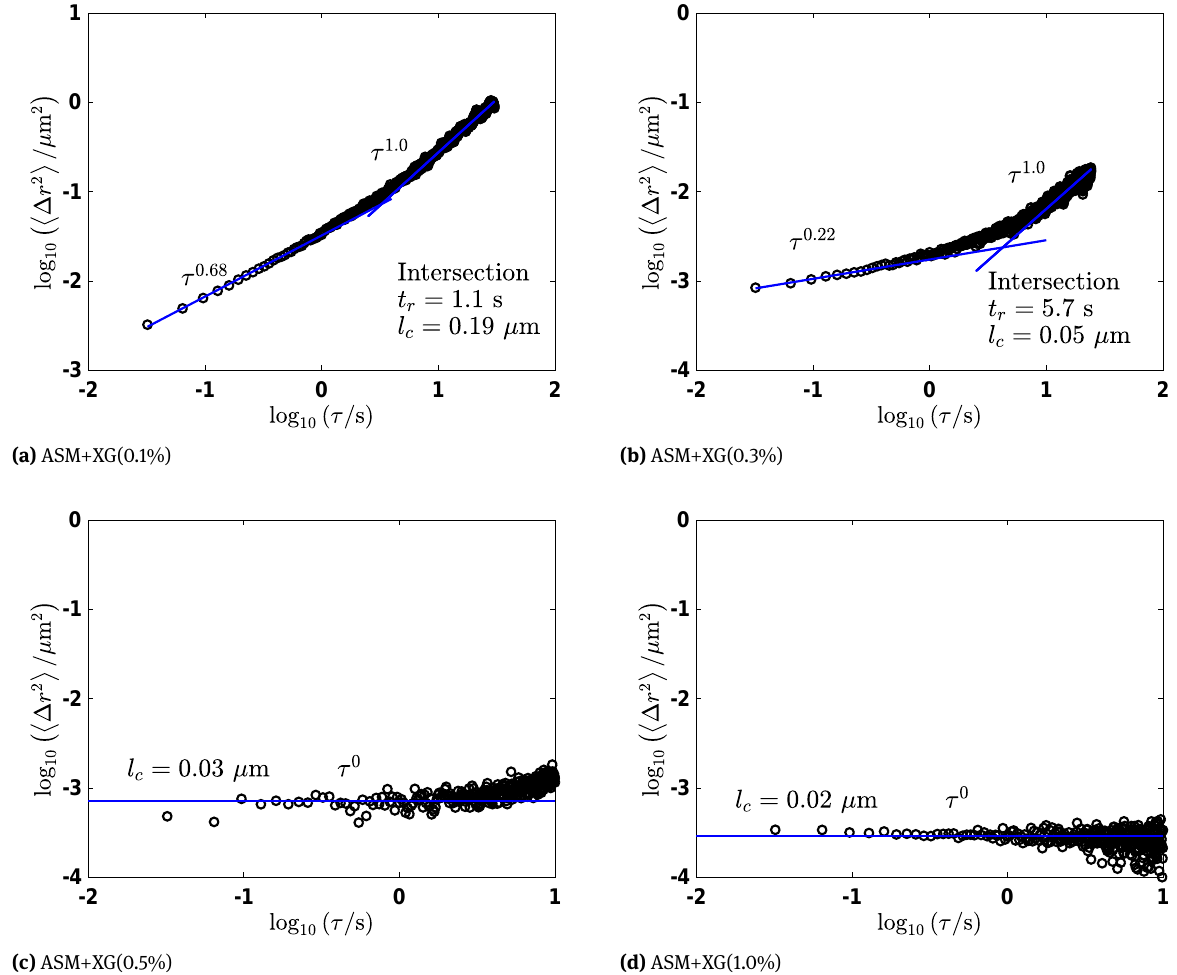
Figure 6: MSD of particles that were suspended in ASM at varying concentrations of XG, C XG ∈ { 0.1, 0.3, 0.5, 1.0 } % . (a) The intersection of subdiffusion and diffusion is at ( t r , ℓ c ) = (1.1 s, 0.19 µ m) . (b) The intersection of subdiffusion and diffusion is at ( t r , ℓ c ) = (5.7 s, 0.05 µ m) . (c) The MSD scales as τ 0 , and ℓ c = 0.03 µ m . (d) The MSD scales as τ 0 , and ℓ c = 0.02 µ m . With an increase of the concentration of XG,